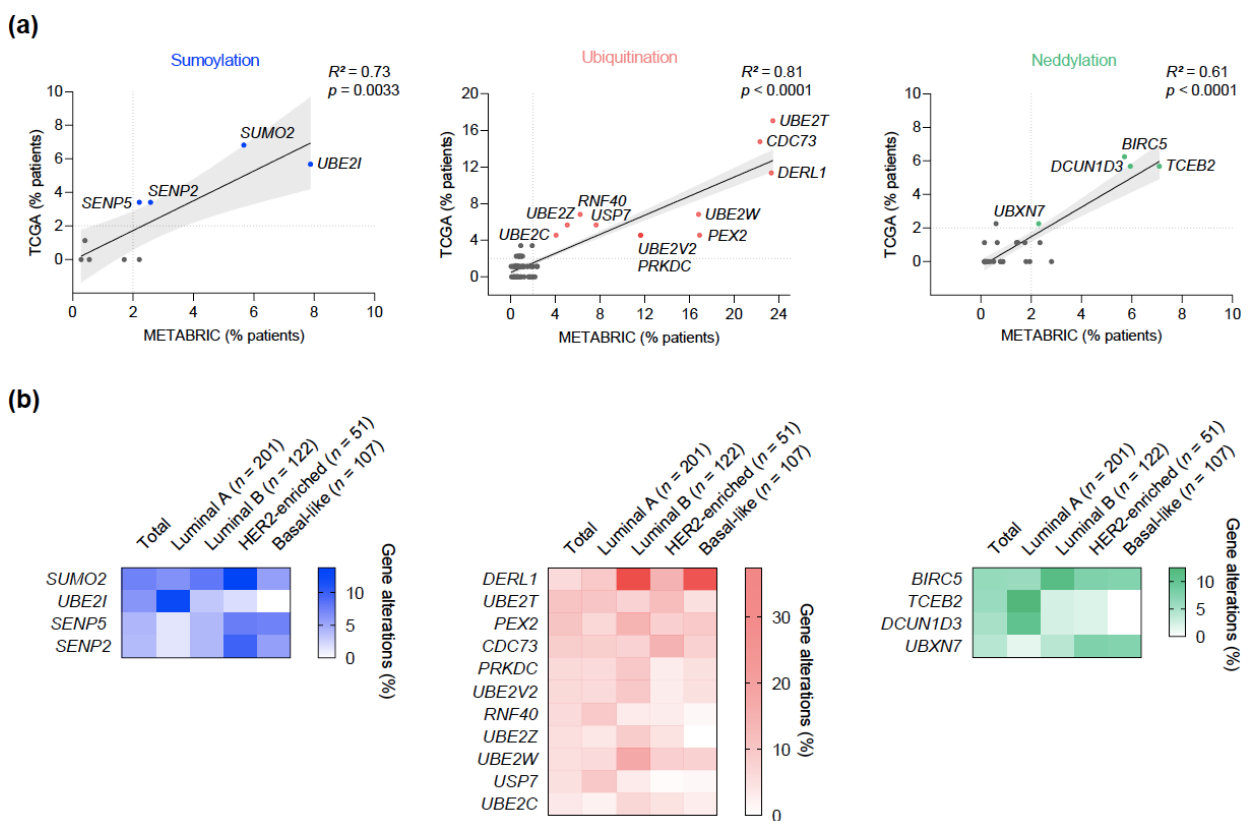
Figure 2. Filtering of gene amplifications. ( a ) Regression analysis of amplification frequencies in the TCGA and METABRIC datasets, highlighting gene amplifications that occur in more than 2% of patients in both. ( b ) Distribution of the frequency of the selected amplified genes across intrinsic subtypes in patients from the TCGA dataset. Population is limited to those patients in which the intrinsic subtype is available in cBioPortal for stratification.